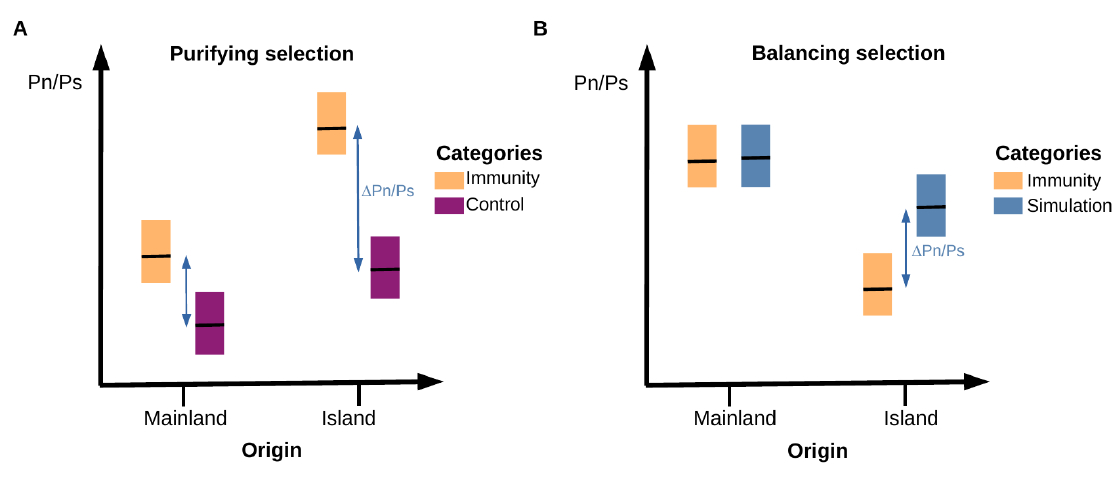
Figure 2: Conceptual diagram showing the expected results under the hypothesis of a relaxation in the selection pressure of the immune genes in island species due to a change in the parasitic community. A) Genes evolving under purifying selection where control genes are randomly selected protein-coding genes. B) Genes evolving under balancing selection where controls are obtained from SLiM simulations of genes evolving under the same balancing selection but different population size. Under the hypothesis of a relaxed selection as a consequence of the reduced diversity of pathogens on island ecosystems, the difference in Pn/Ps between categories ( Δ Pn/Ps) is expected to be different between species’ origin, leading to a statistical interaction between gene categories and origin.